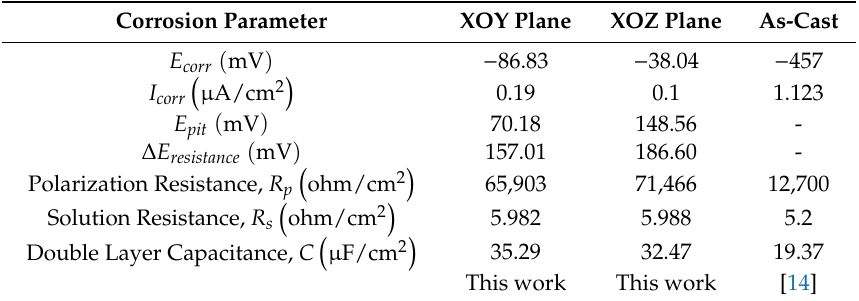
Figure 11. ( a ) the Potentiodynamic polarization curves and ( b ) the EIS results of the XOY plane and XOZ plane for the SLM produced CoCrFeMnNi alloy in the 3.5 wt % NaCl solution at room temperature. Table 4. Electrochemical and equivalent circuit parameters of the XOY plane and XOZ plane for the